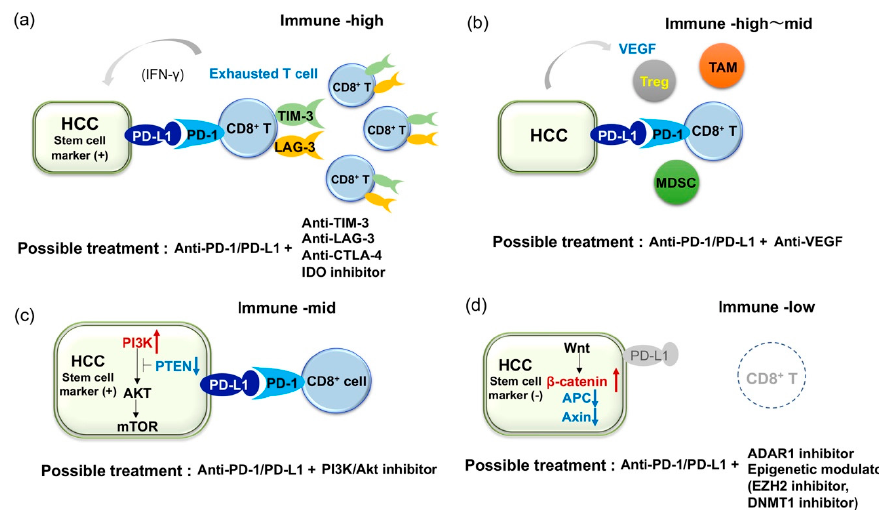
Figure 2. Illustrative figures of expected combination therapies for HCC patient refractory to immune checkpoint monotherapies. ( a ) In cases with expression of PD-L1 in HCC but multiple co-inhibitory receptors on tumor infiltrates, dual blockade of PD-1/PD-L1 and anti-TIM-3 or anti-LAG-3 should be required. ( b ) Because VEGF is known to play an important role for induction of immune suppressive molecules and cells, dual blockade of PD-1/PD-L1 and VEGF axis should be effective. ( c ) In cases with expression of PD-L1 and activating mutation in the PI3K-mTOR pathway in HCC, dual blockade of PD-1/PD-L1 and the PI3K-mTOR pathway might be effective. Notably, both anti-PD-1/PD-L1 and anti-PI3K-mTOR agents could target cancer stem cells (CSCs). ( d ) In cases with a lack of CD8 + T cell infiltration in tumor (activating mutation in the β -catenin pathway is common in this type), ADAR1 inhibitor and epigenetic modulator might induce the recruitment of CD8 + T cells into tumor and contribute to the induction of anti-tumor immunity.